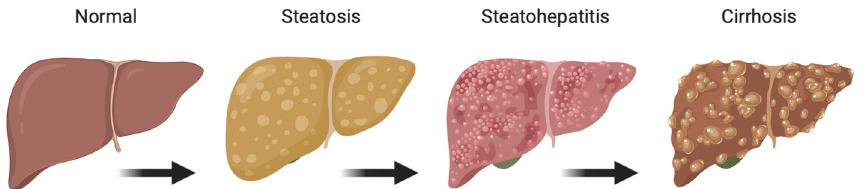
Figure 1. Stages of non-alcoholic fatty liver disease (NAFLD). Figure created with BioRender (accessed on 7 February 2022).